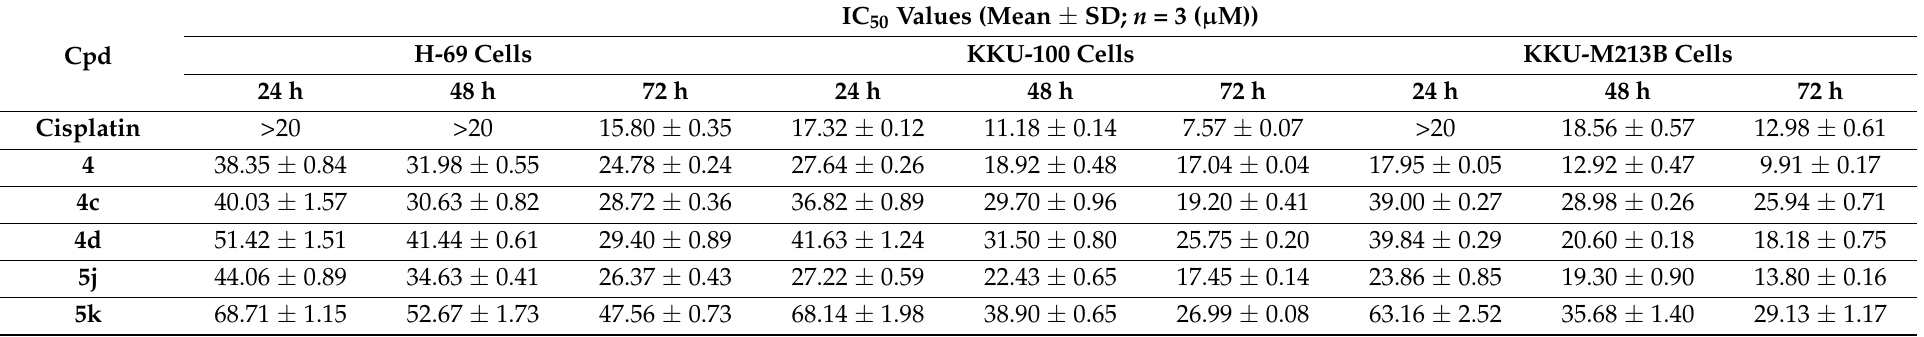
Table 4. Antiproliferative activities of potent HDAC inhibitors against H-69 and cholangiocarcinoma cell